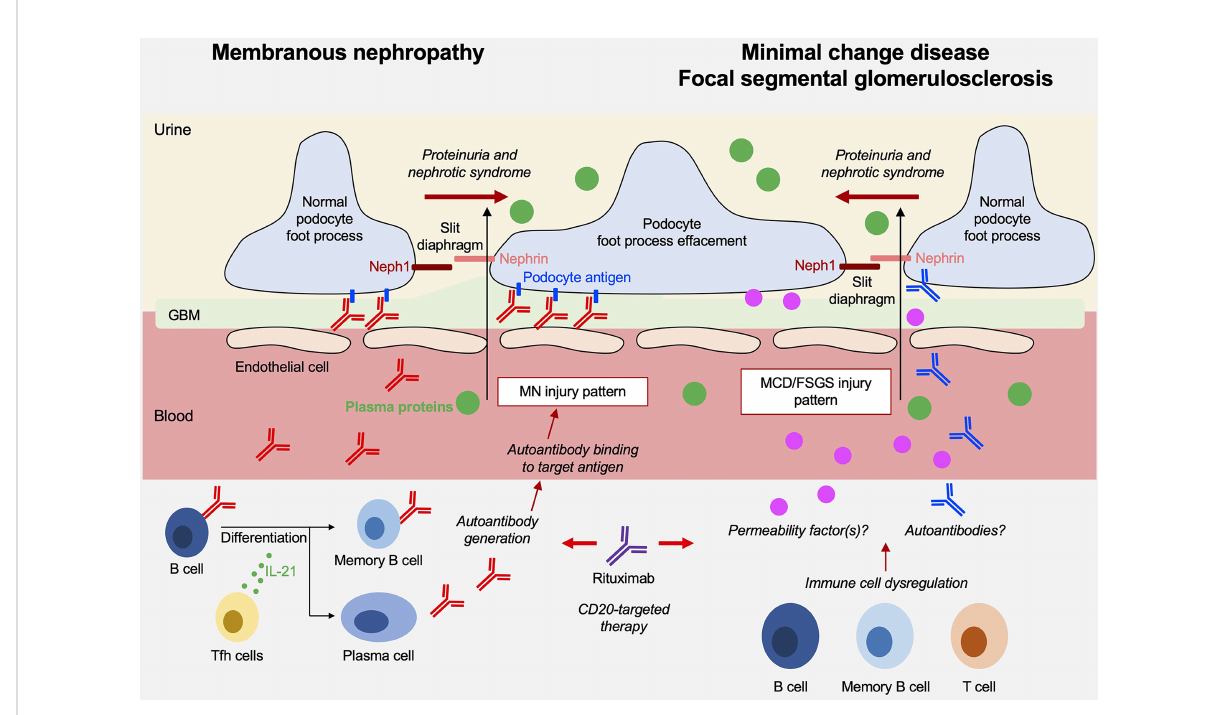
FIGURE 1 Overview onthe pathogenesis ofmembranous nephropathy (MN)and minimal changedisease (MCD)/focal segmental glomeruloscleroses